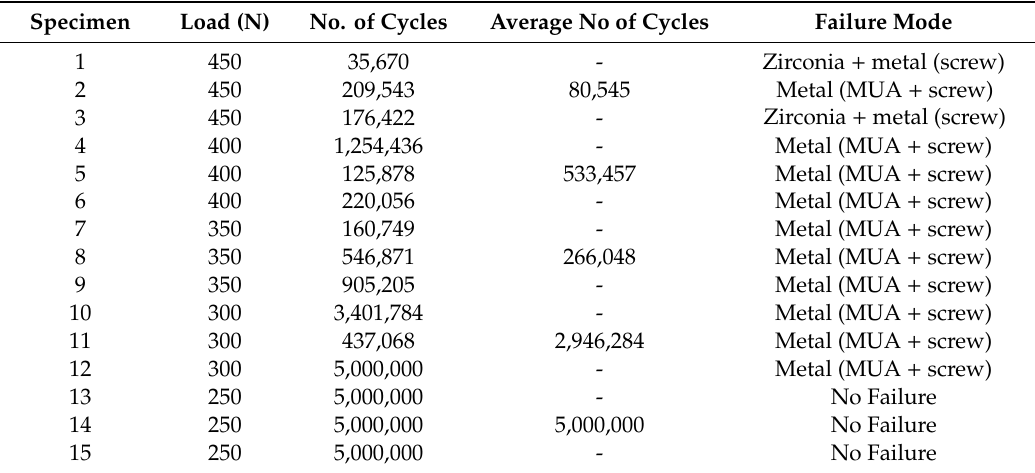
Table 2. Fatigue test results for group A (screwed restoration).